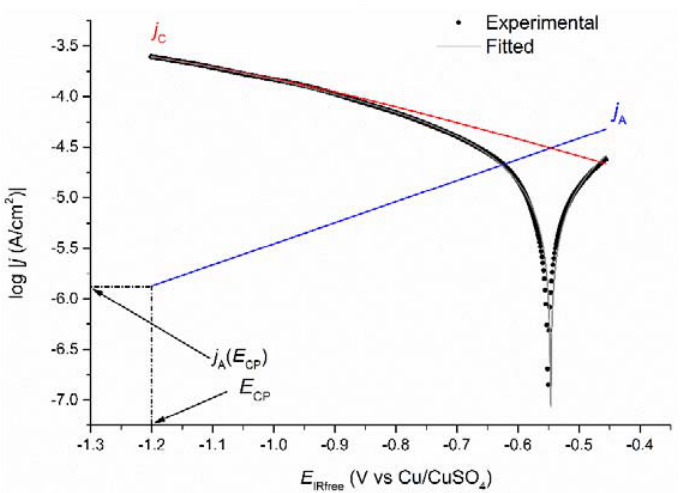
Figure 9. Polarization curves for coupon WE CP2 at day 49: experimental-curve (black dots), fitted-curve (grey full line), anodic (blue line) and cathodic (red line) components drawn using the obtained electrochemical parameters.